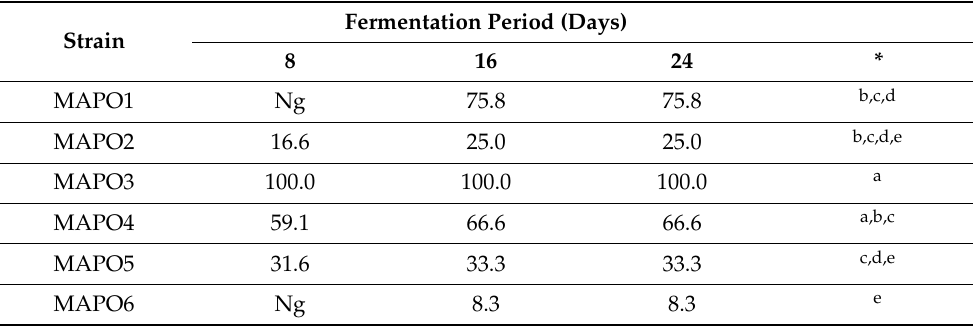
Table 2. Percentage of indigo dye decolorization by isolated fungi cultured in a shake flask with carbon-limited medium containing 150 mg L − 1